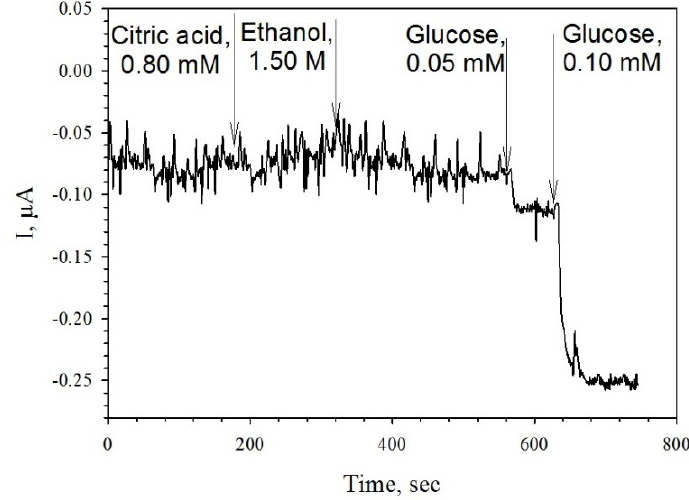
Figure 7. Amperometric signals of a PMCs / GOx / MWCNTs-modified biosensor upon addition of citric acid, ethanol, or glucose. 287 Table 3. Sensitivity and limit of detection for some glucose biosensors based on GOx. 288